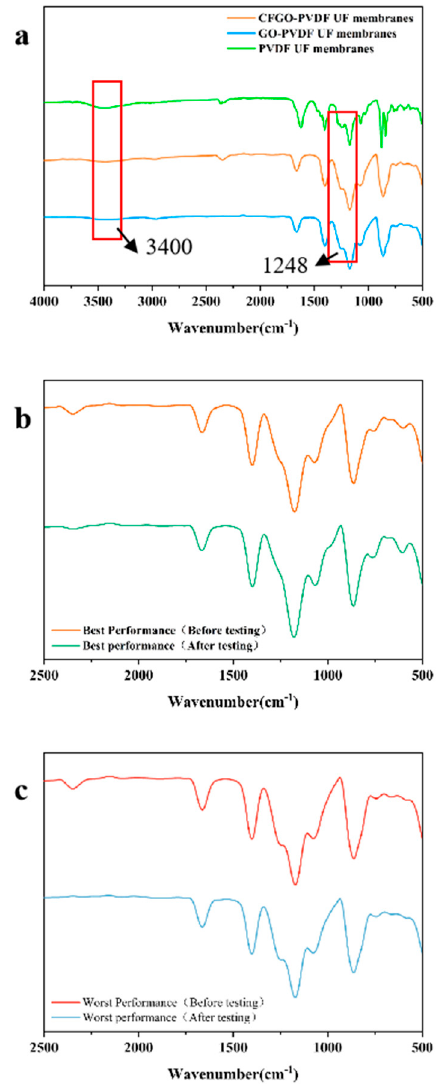
Figure 3. Infrared analysis of CFGO-PVDF ultrafiltration membranes. ( a ) The infrared spectra of CFGO co-blended PVDF ultrafiltration membranes with normal GO-PVDF ultrafiltration membranes and pure PCDF ultrafiltration membranes; ( b ) IR spectra of CFGO composite ultrafiltration membrane with the best sulfapyridine removal effect; and ( c ) IR spectra of CFGO composite ultrafiltration membrane with the worst sulfapyridine removal effect.